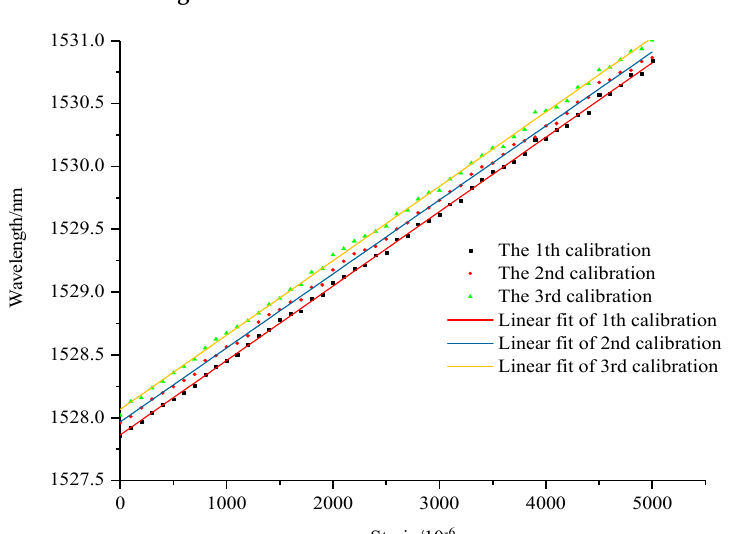
Figure 10. Calibration of bare FBG sensor.